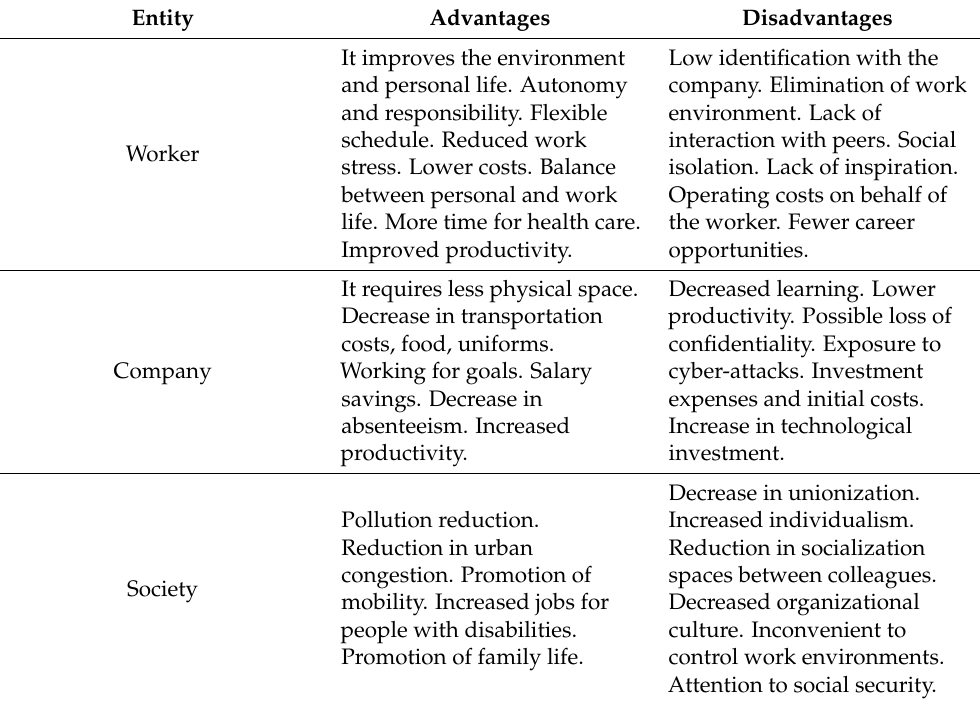
Table 1. Advantages and disadvantages of remote